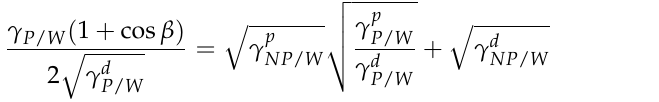
and polar component, γ p of the silica nanopar- NP / W NP / W